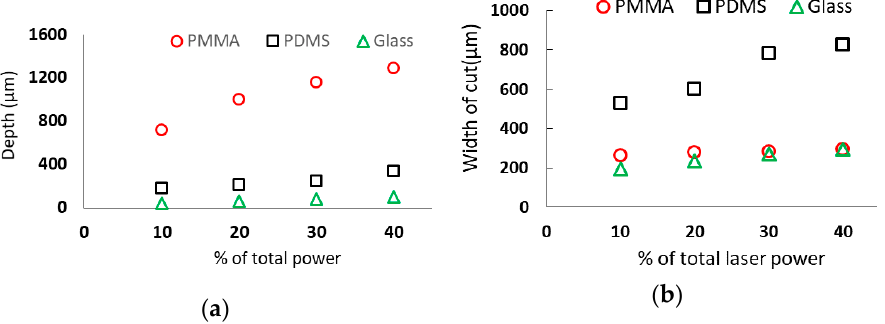
Figure 4. Effect of laser power on microchannel depth and width. The specimen was placed at the focal distance of the CO 2 laser machining system. The laser system was set at single pass, scanning speed at 10 mm/s and current at 20 mA. The total laser power was 45W; ( a ) shows the depth and ( b ) width of the microchannels as a function of laser power.